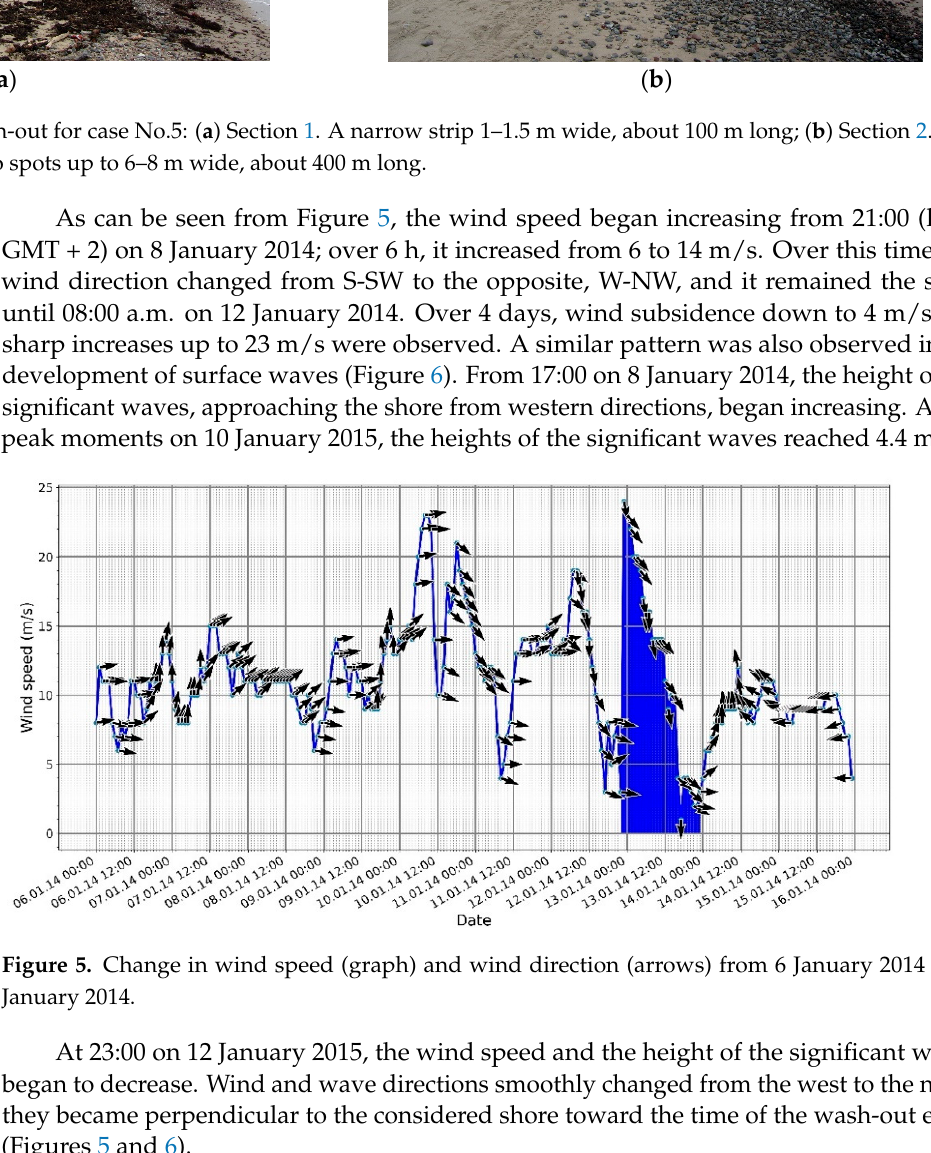
Figure 6. Change in the height (graphs) and direction (arrows) of the significant waves from 6 Jan- uary 2014 to 16 January 2014.